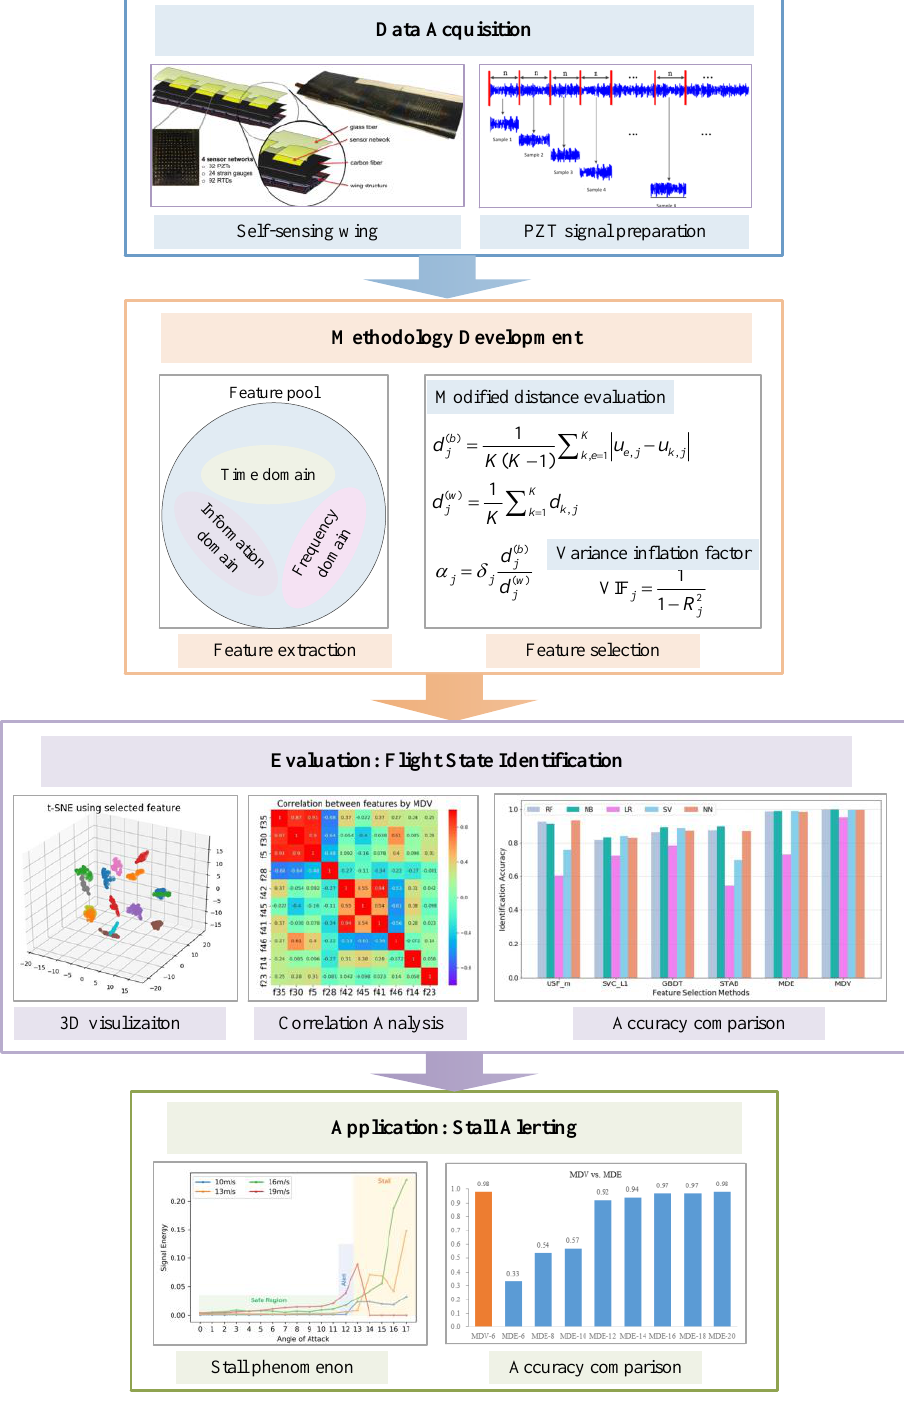
Figure 2. Framework of the proposed methodology.